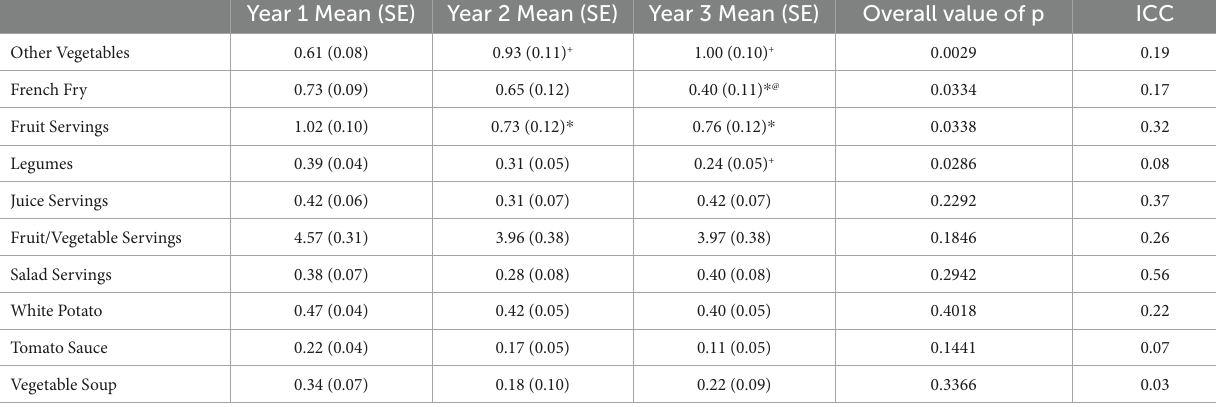
TABLE 3 Dietary changes related to various fruits and vegetables among cohort participants, 2019–2022.